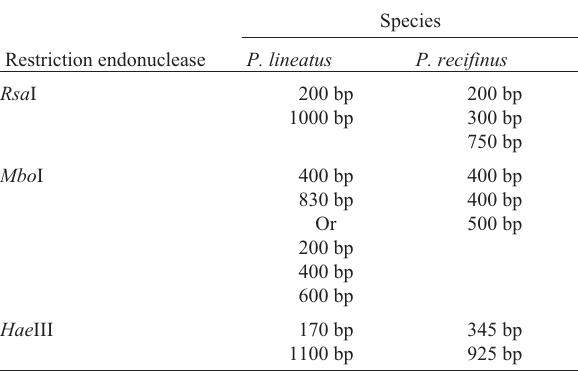
Table 1 - Haplotypes: cleavage pattern for each species vs. restriction